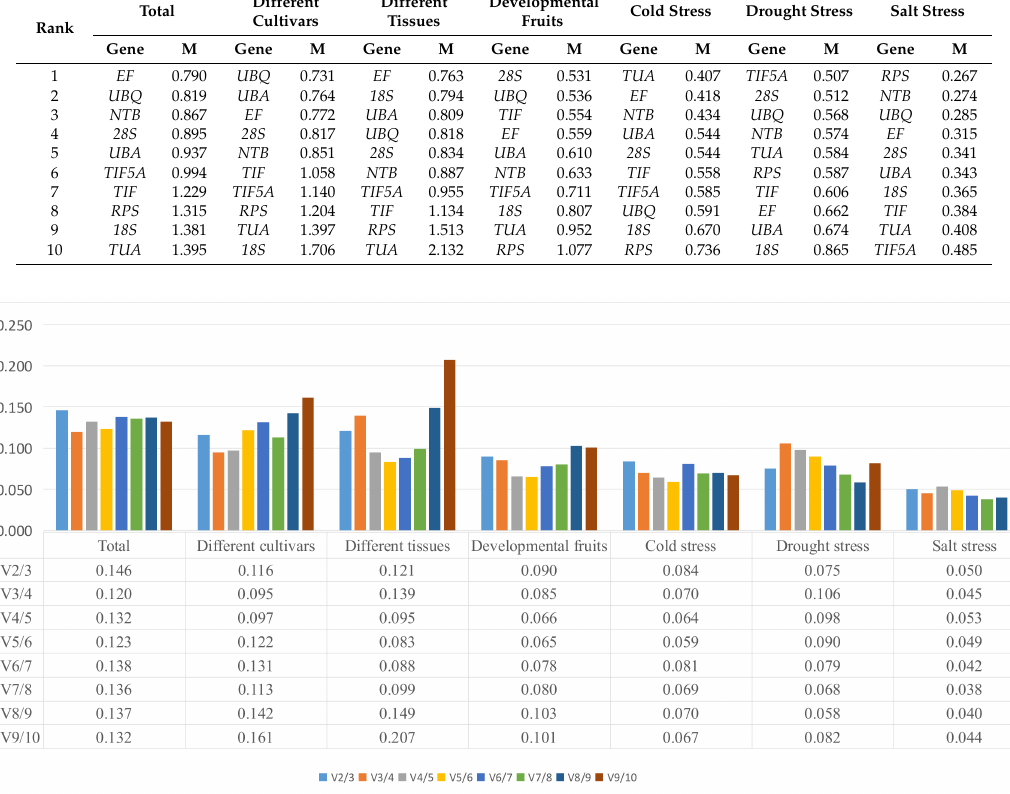
Figure 4. Determination of best reference gene number calculated by geNorm pairwise variation (Vn/Vn +